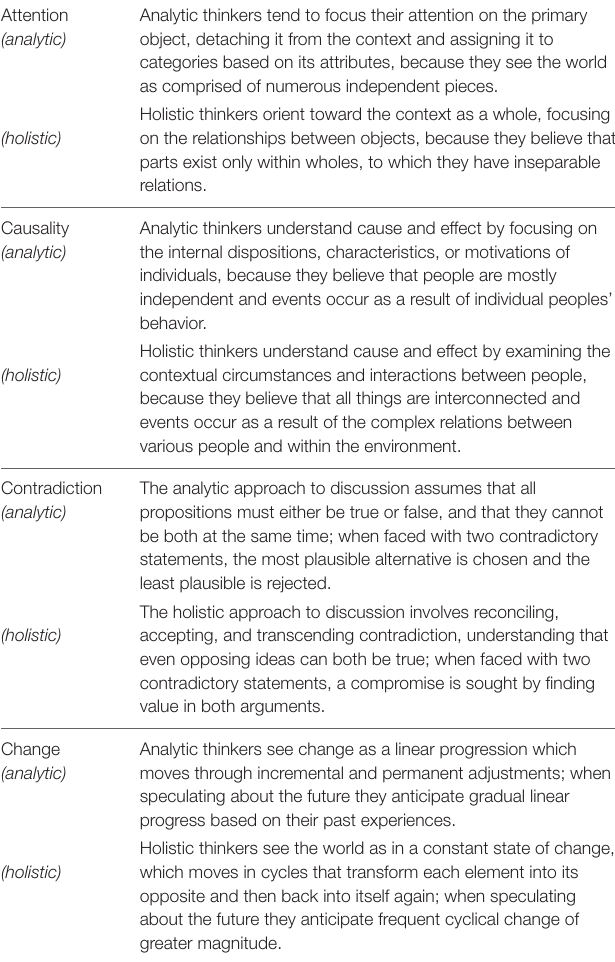
TABLE 1 | Study 1 – definitions of the Holistic Cognition Scale (HCS)